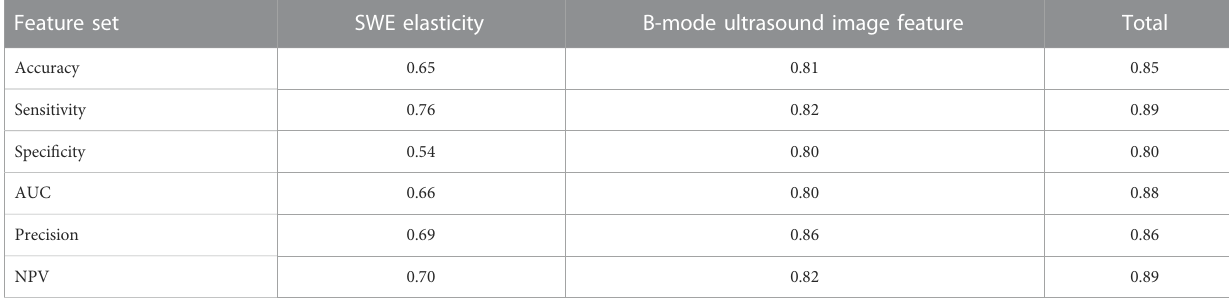
TABLE 5 Classi fi cation